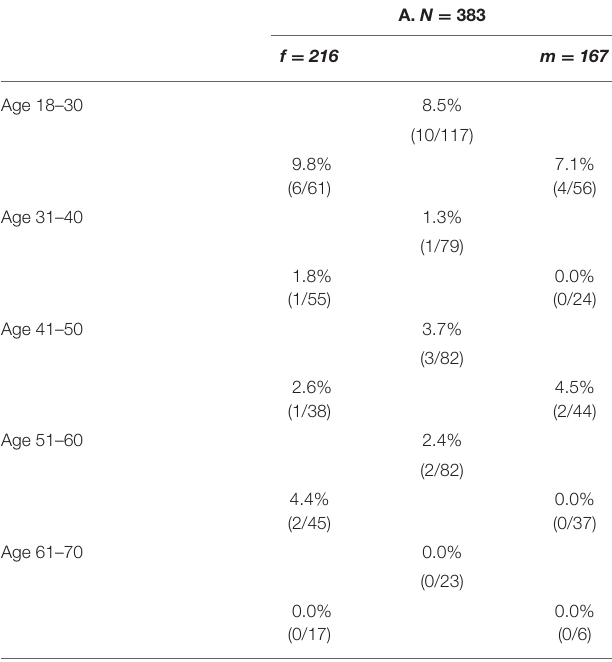
TABLE 3 | Distribution of suspected MD (MDS-16 score over 40) according to age group, in Sample A, i.e., the community sample ( N = 383) (in